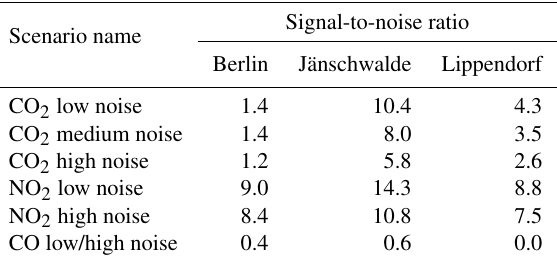
Table 6. Median signal-to-noise ratios for signals of Berlin, Jän- schwalde and Lippendorf using different uncertainty scenarios. The signals were computed as largest local mean values using a local neighborhood size n s of 37 and 5 for cities and power stations, re-